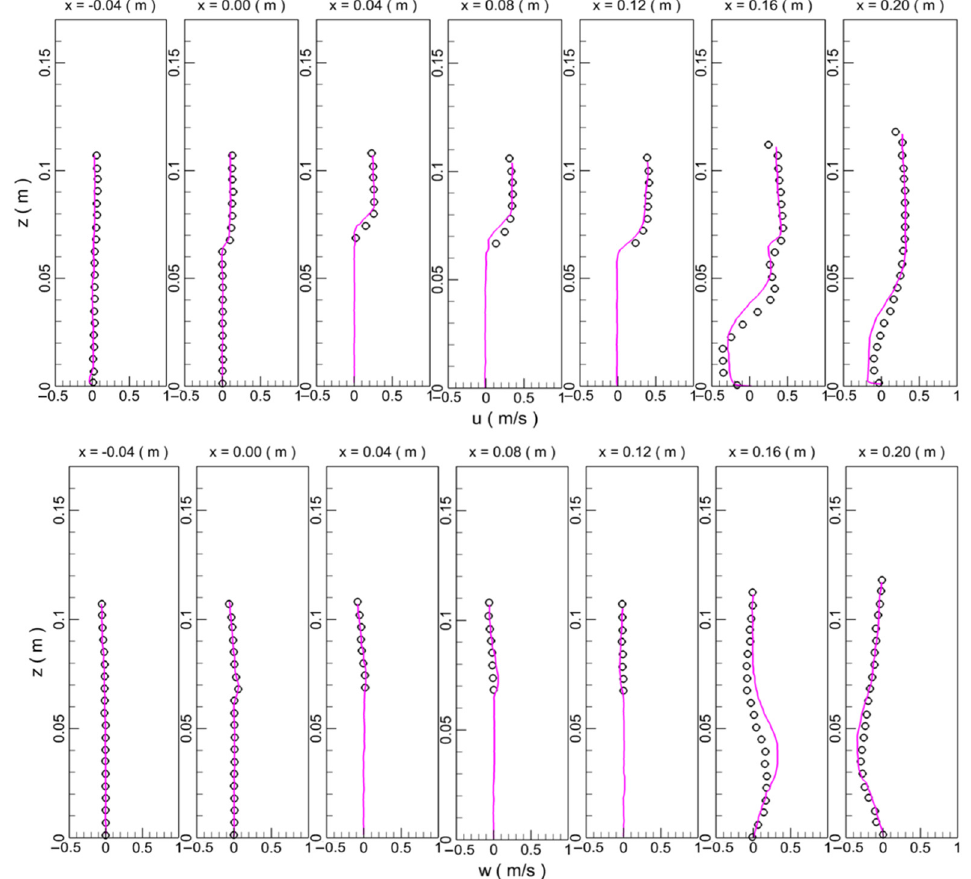
Figure 3. Comparison of velocity distribution between computation and measurement; (u) horizontal velocity; (w) vertical velocity; at t = 1.65